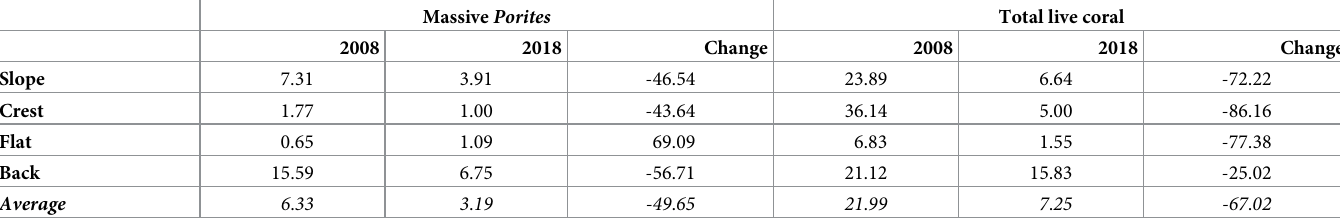
Table 1. Percentage of live hard coral cover in 2008 and 2018 at the study site, Lizard Island, on the Great Barrier Reef. Data for 2008 sourced from